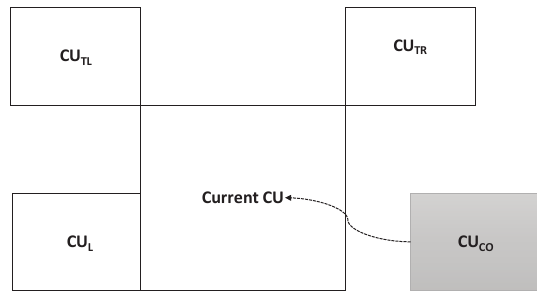
Figure 4. Spatiotemporal neighborhood